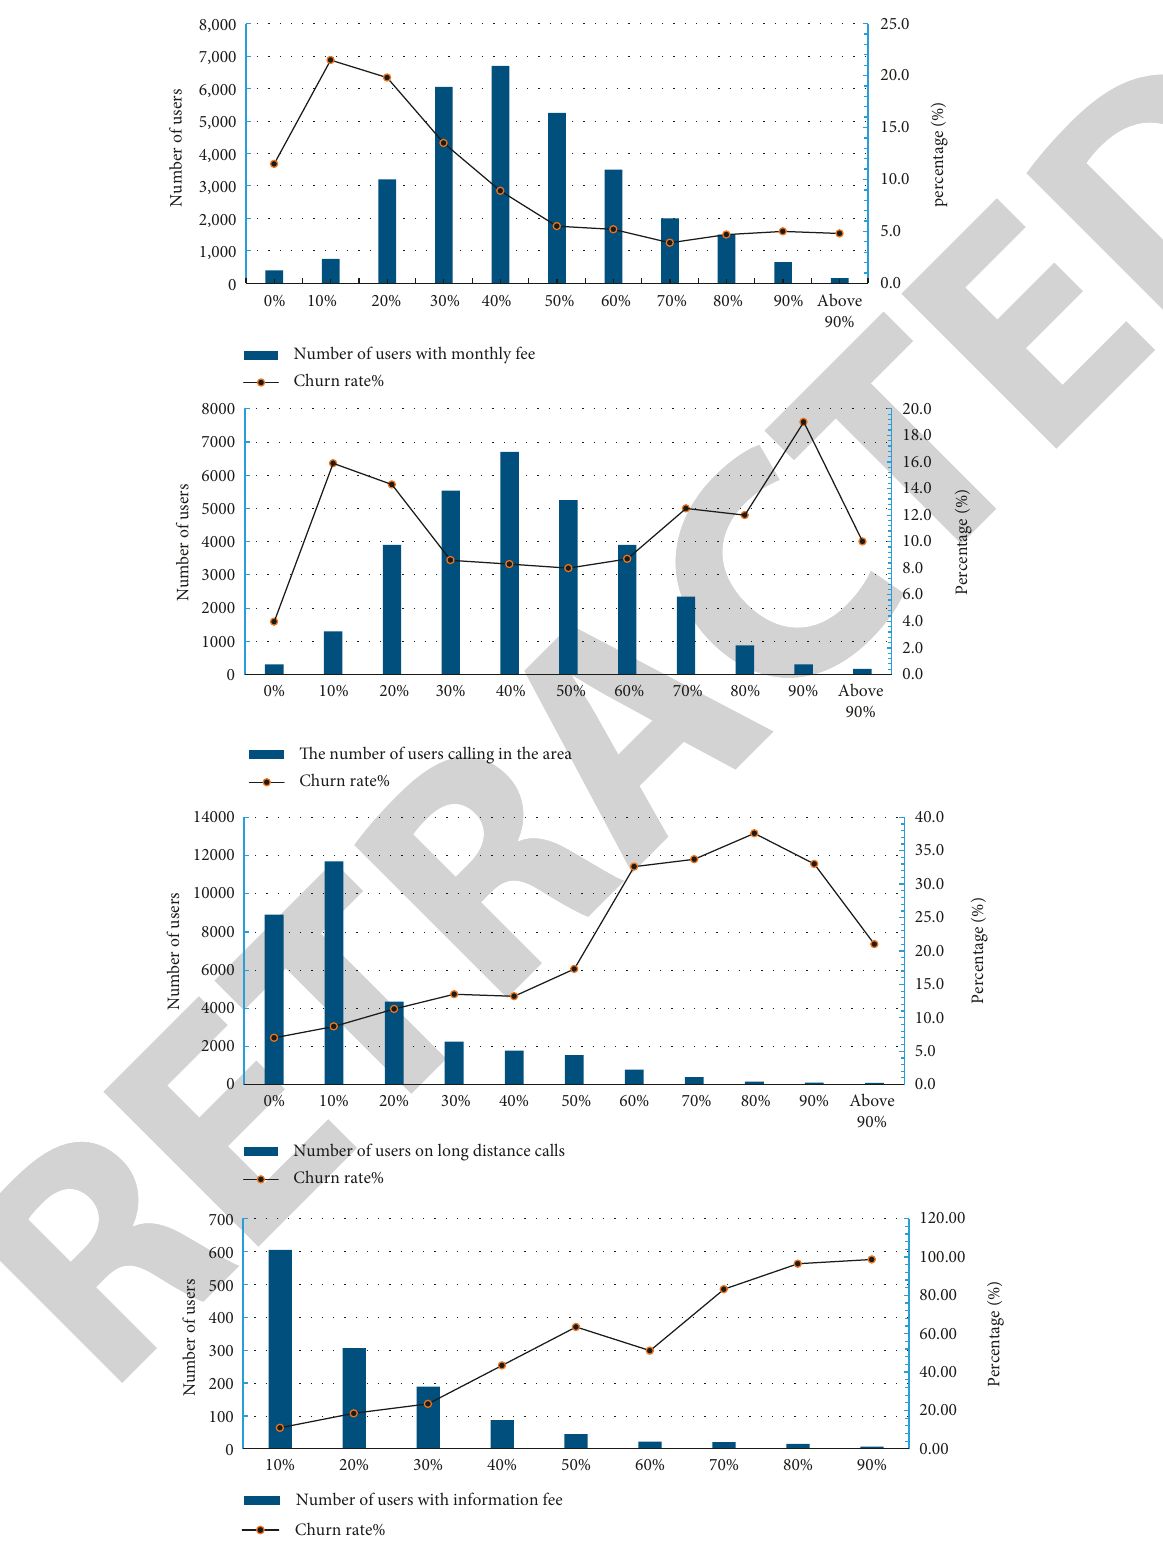
Figure 10: Relationship between customer churn and four cost